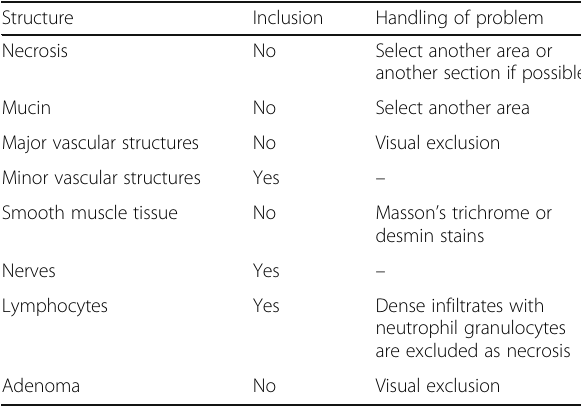
Table 6 Scoring criteria for semi-quantitative estimation of tumour stroma ratio with a list of structures to be included or